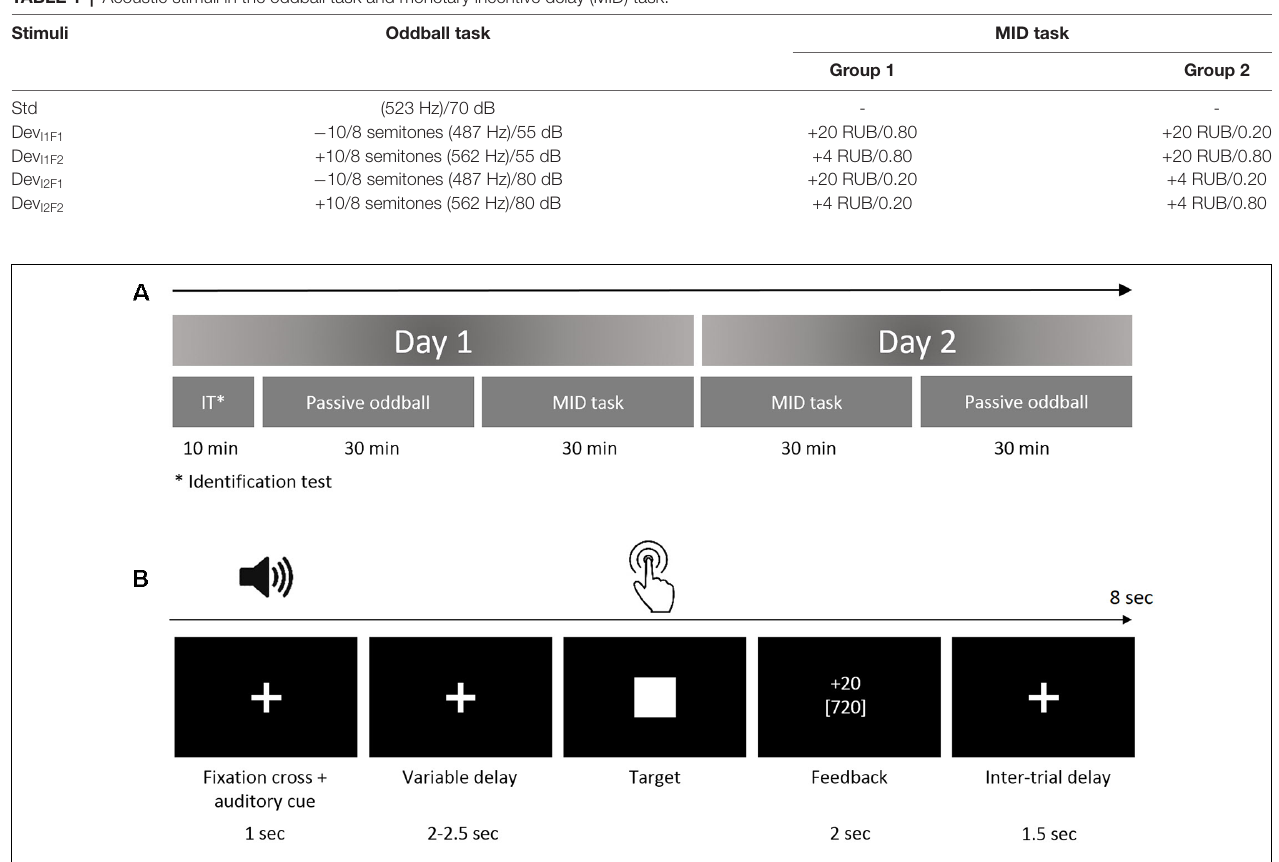
FIGURE 1 | (A) Study protocol. The subjects performed the oddball task and monetary incentive delay (MID) task on two successive days. The identification test prior to the first oddball session was designed to ensure that the participants could discriminate among the auditory stimuli. (B) The structure of the trial in the auditory version of the MID task. In the beginning of each trial (first box), the participants were exposed to acoustic cues encoding the prospective gain magnitude [4 or 20 Russian rubles (RUB)] and the probability of a win ( p = 0.80 or p = 0.20). After a variable anticipatory delay period (second box, fixation cross, duration = 2,000–2,500 ms), the participants responded with a single button press as quickly as possible after the presentation of a visual target (third box, white target square). Next, 800 ms after the button press (the end of each trial), a feedback screen (fourth box, duration = 2,000 ms) was presented. During the feedback, the top number indicated the amount of money won during that trial, and the bottom number indicated the participant’s total amount won. The overall duration of a single trial was 8 s on average.